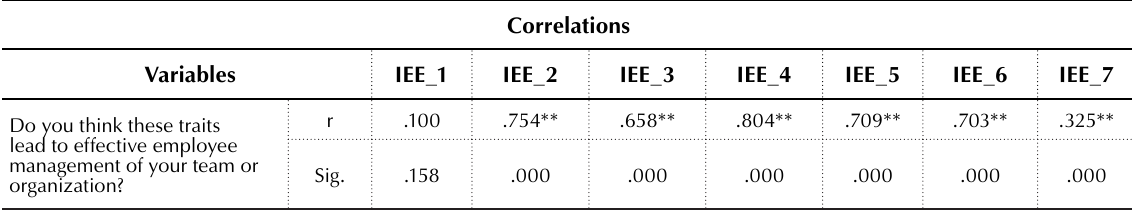
Table 1. Correlation analysis on